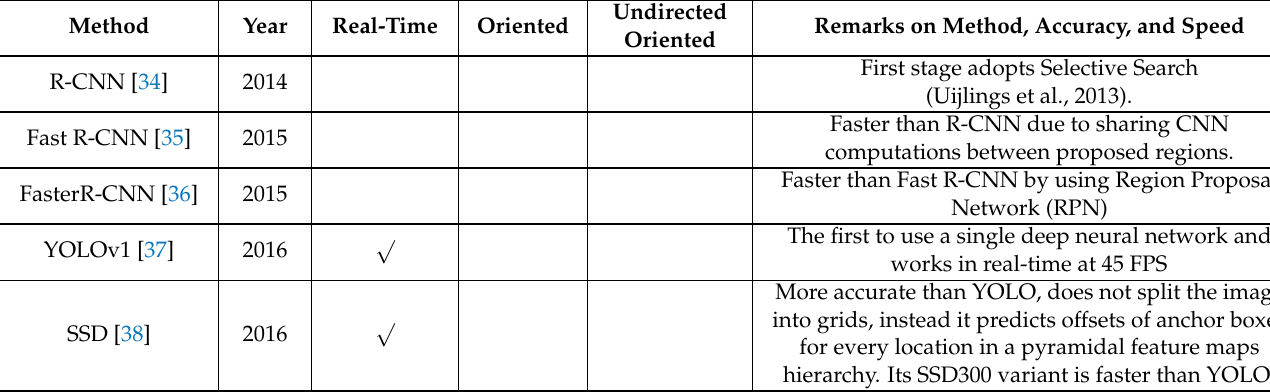
Table 1. Object detection